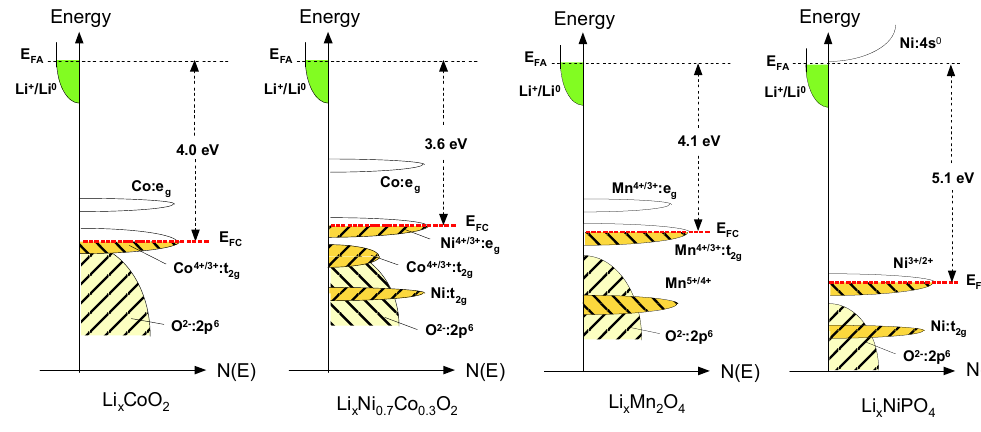
, the Ni 4+/3+ redox couple for LiNi 2 O and the Ni 3+/2+ redox couple for LiNiPO 2 4